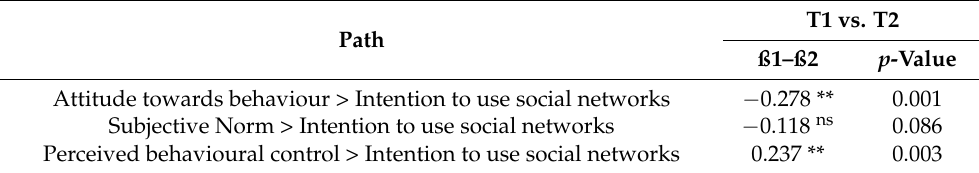
Table 4. PLS multigroup analysis of the factors in the TPB model before and after confinement in elderly adults from Chile. T1 vs. T2 Path ß1–ß2 p -Value Attitude towards behaviour > Intention to use social networks − 0.278 ** 0.001 Subjective Norm > Intention to use social networks − 0.118 ns